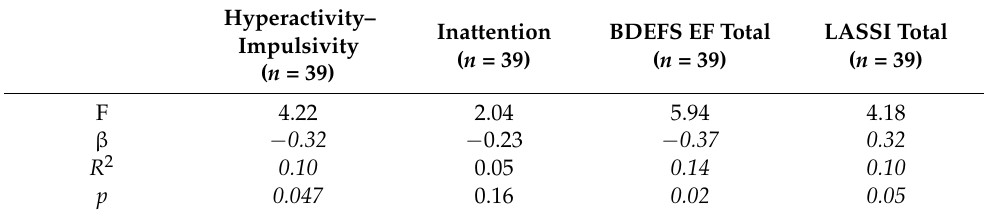
Table 3. Regression analyses with Inattention, Hyperactivity–Impulsivity, BDEFS EF total, and LASSI total as predictors and the subjective value of € 100 after 1 year as the dependent